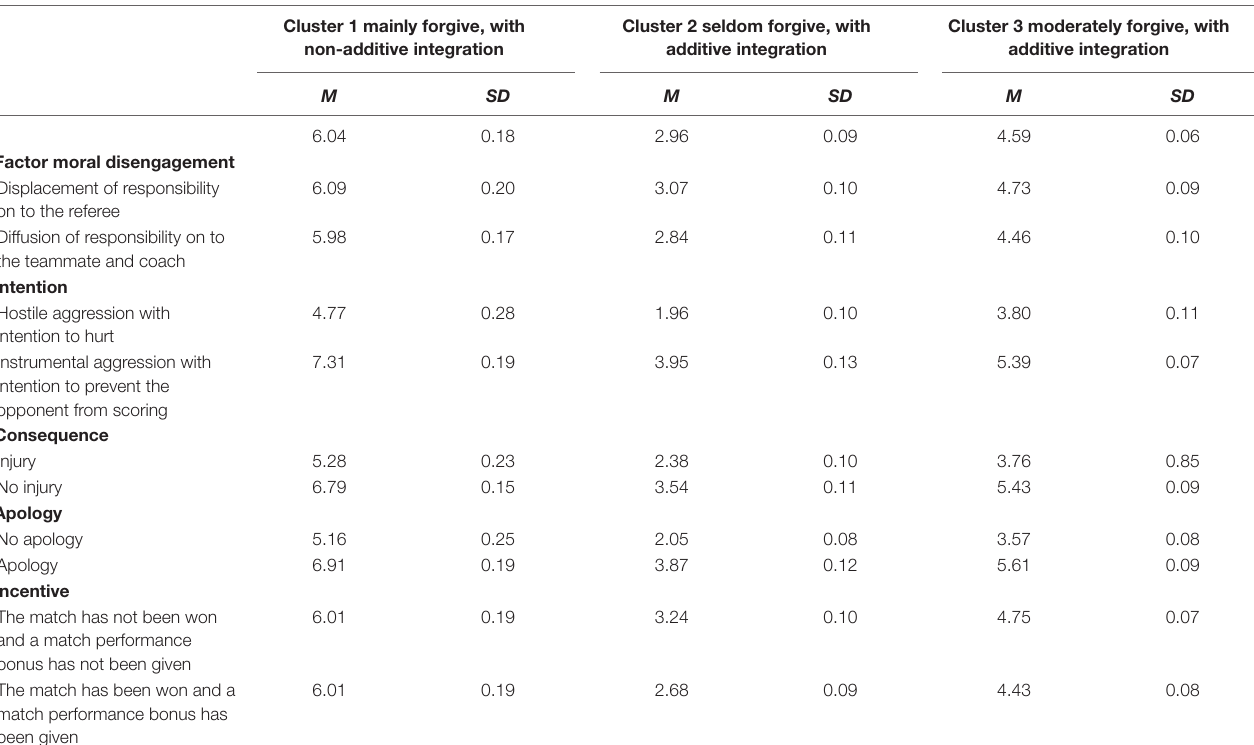
TABLE 2 | Mean and SD scores for each factor in the three